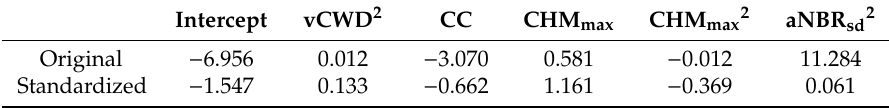
Table 5. Intercept and coe ffi cients for continuous part of the best zero-adjusted gamma model. Values are presented for models created with the original training data and models using standardized predictor variables (mean of zero and standard deviation of one). Variables include squared area of visible coarse woody debris (vCWD), canopy closure (CC), height of tallest tree (CHM max ), squared height of tallest tree (CHM max2 ) and squared standard deviation of active normalized burn ratio (aNBR sd2